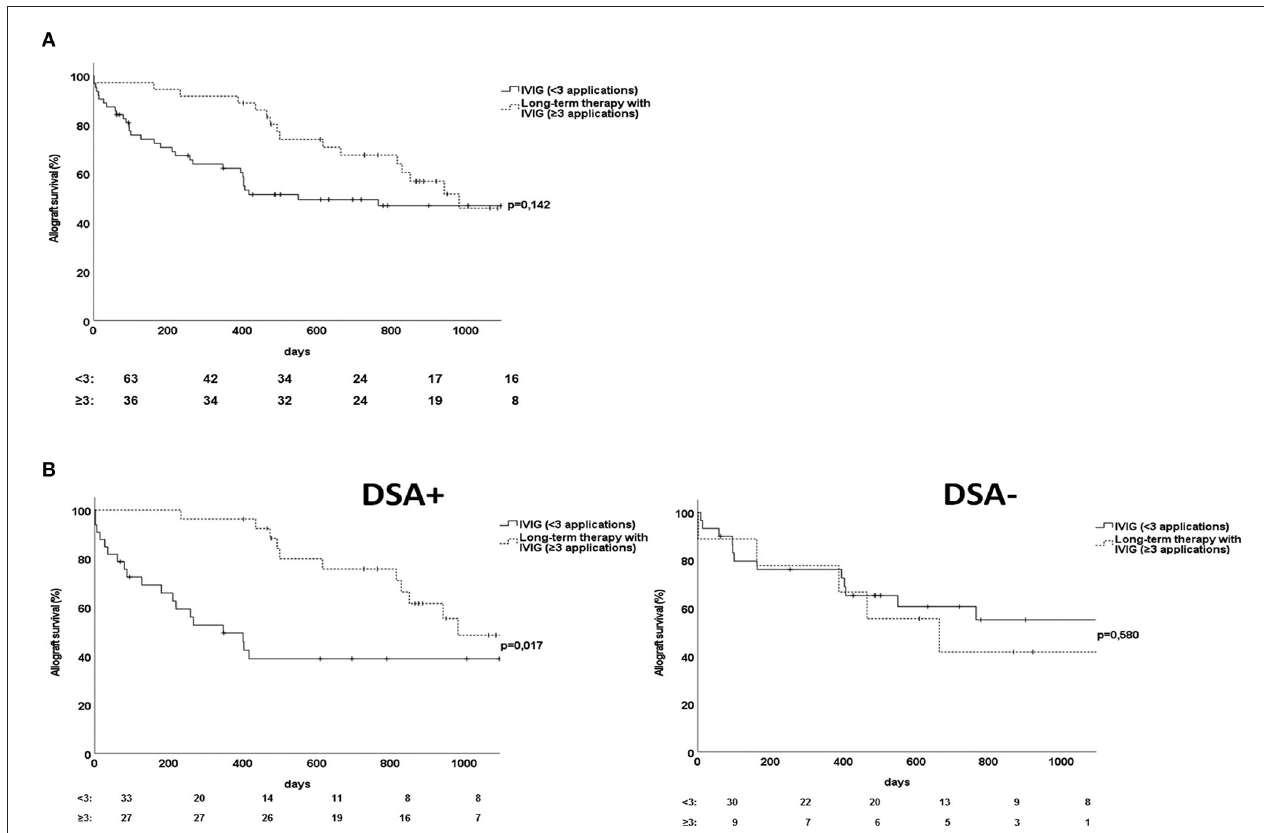
FIGURE 5 | Effect of long-term therapy with IVIG on renal allograft survival of recipients with persistent antibody-mediated rejection. (A) Comparison of allograft survival between recipients who were treated with repetitive applications of IVIG over more than 1 year vs. recipients without long-term therapy with IVIG. (B) Comparison of the effect of long-term therapy with IVIG on allograft survival between recipients with DSA-positive vs. DSA-negative ABMR. ABMR, antibody-mediated rejection; DSA, donor-specific antibody; IVIG, intravenous immune